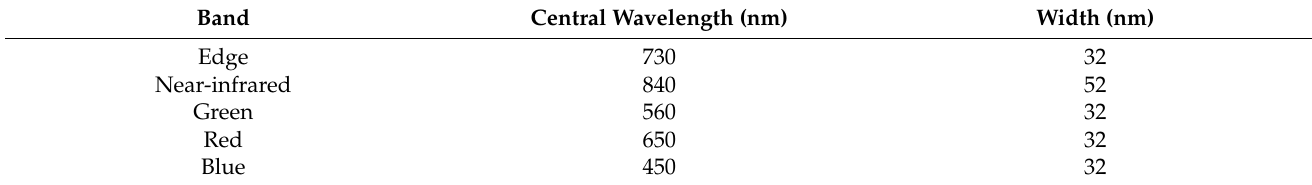
Table 2. Spectral sensor information.